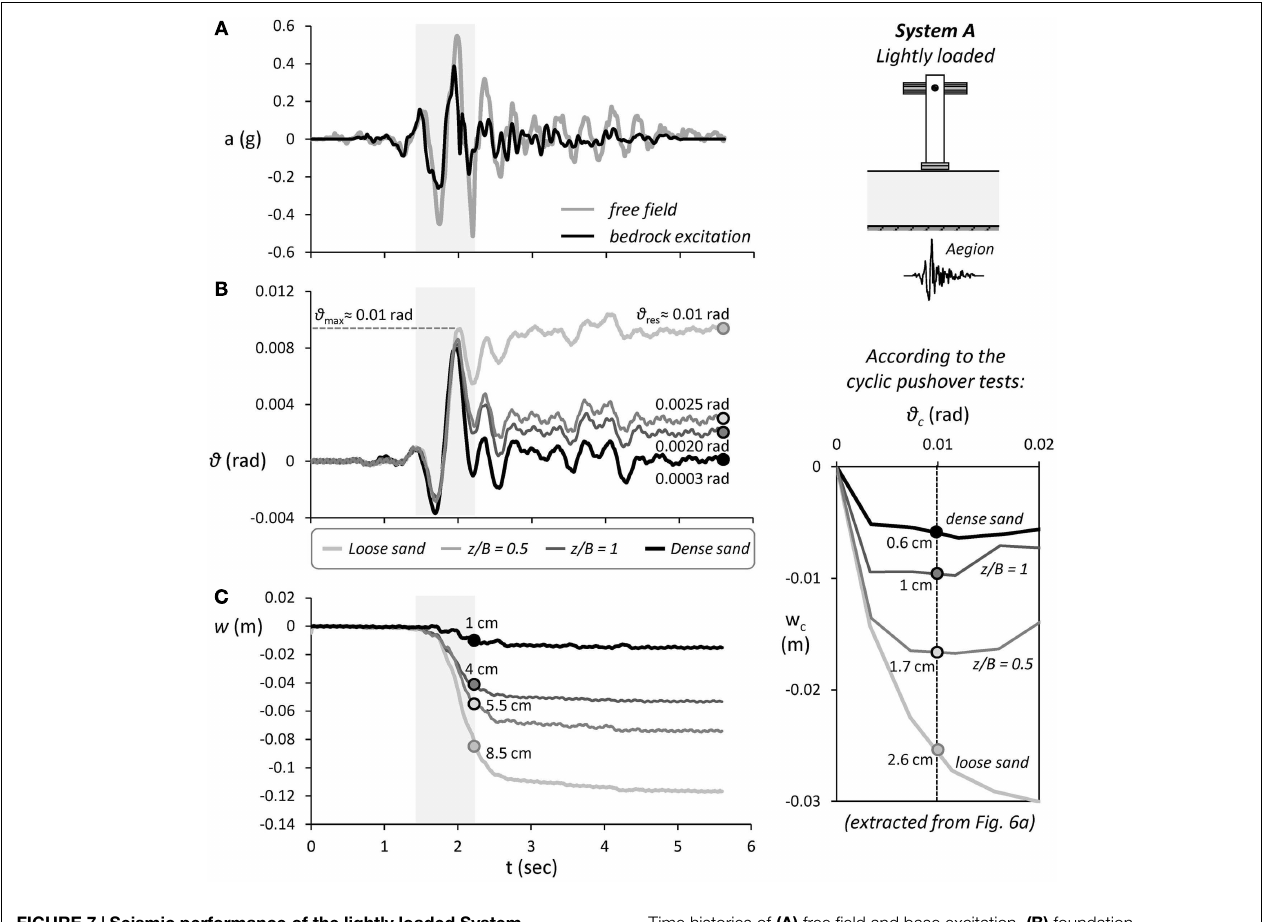
FIGURE 7 | Seismic performance of the lightly loaded System A subjected to moderate seismic shaking using the Aegion record as excitation–comparison of shallow soil improvement with poor (loose sand) and ideal (dense sand) soil conditions .